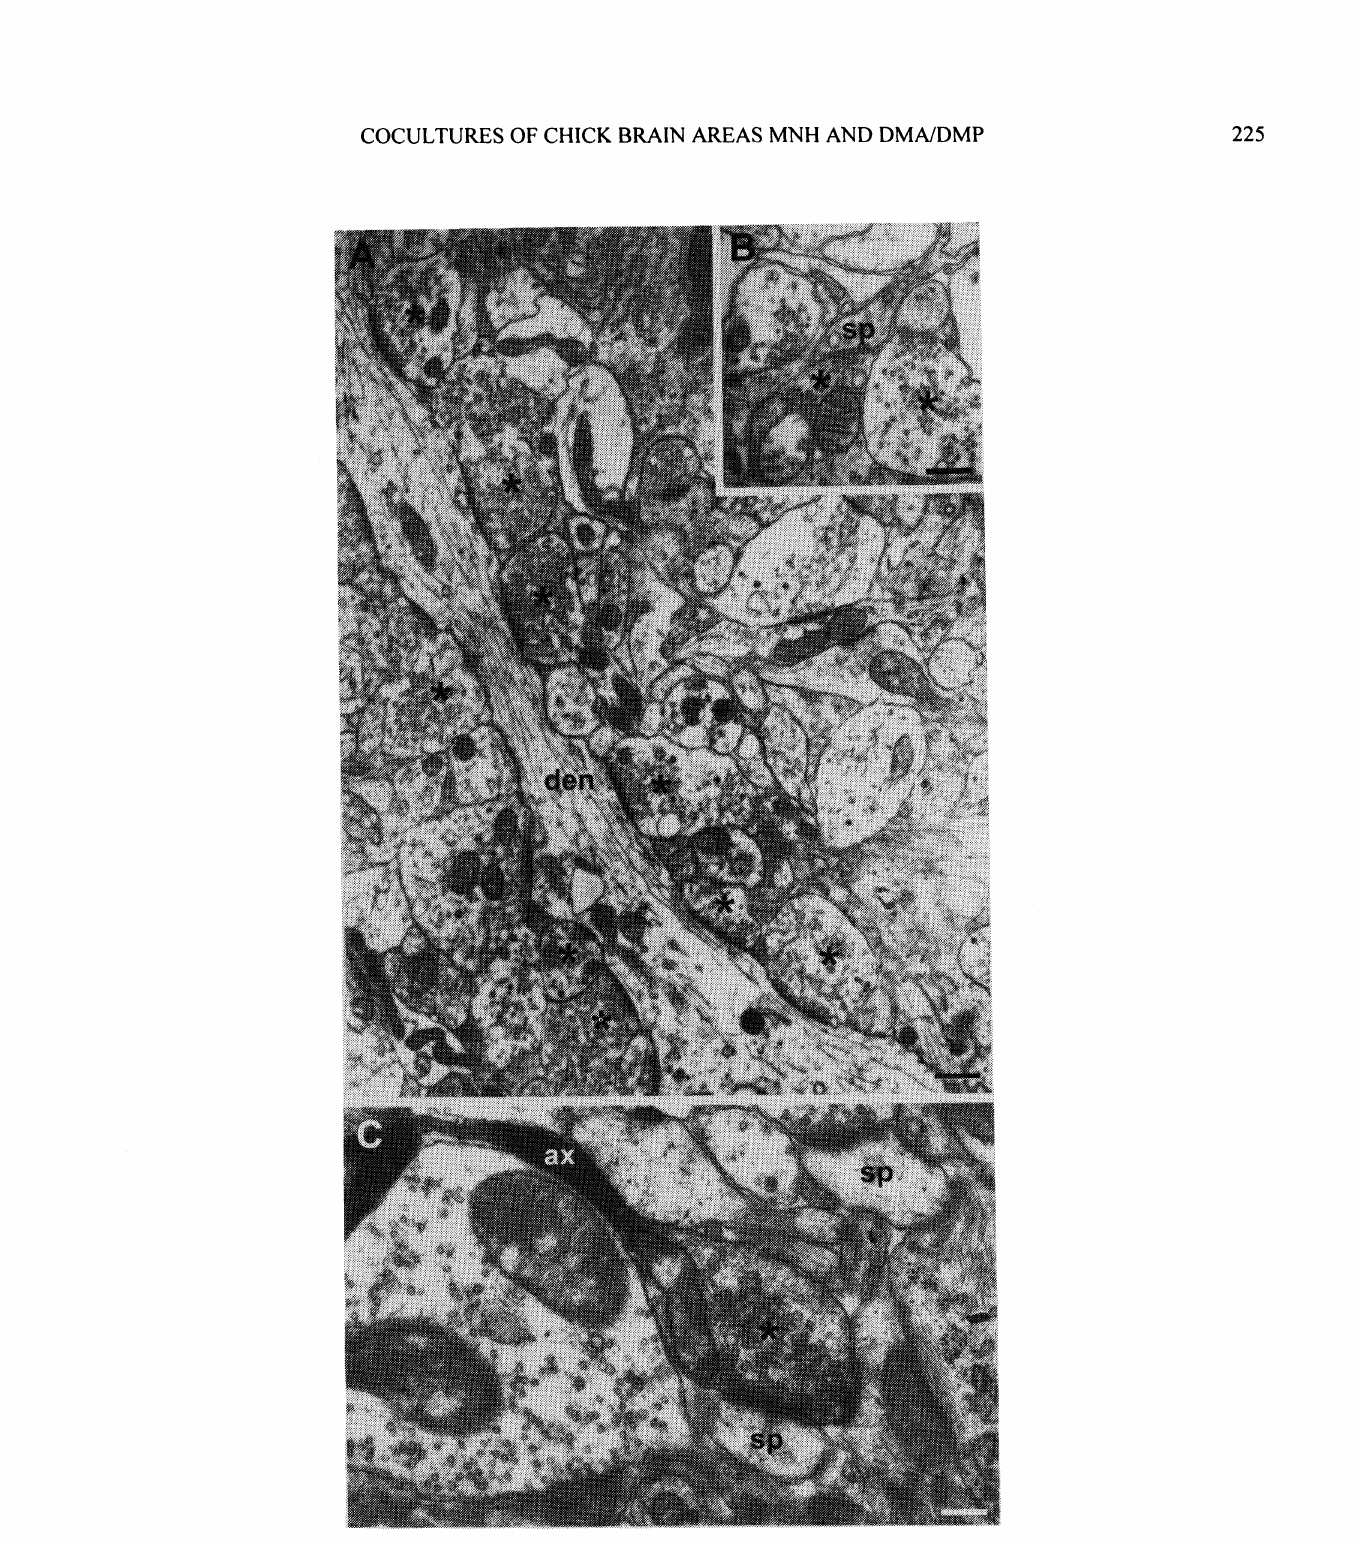
Fig. 3: A: MNH part of a coculture (14 DIV). A dendrite (den) of an MNH neuron is covered with numerous shaft synapses (asterisks). Scale bar: lam. B: Example of a dendritic spine (sp) and two presynaptic terminals (asterisks). Scale bar: 500 nm. C: Dil labeled thalamic axon terminal within the MNH part ofthe coculture (14 DIV). While the axon (ax) is stained by the electron dense product of Dil photoconversion, the synaptic bouton (asterisk) is not labeled and a presynaptic mitochondrion and synaptic vesicles are visible. The bouton contacts a dendritic spine (sp). Scale bar: 250